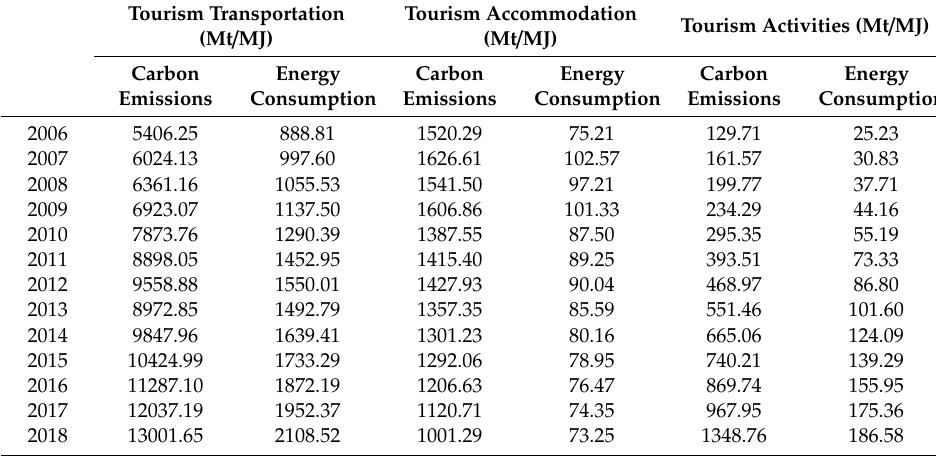
Table 1. The estimations of the carbon emissions and the consumption of energy in tourism industry in China, 2006 to 2018.